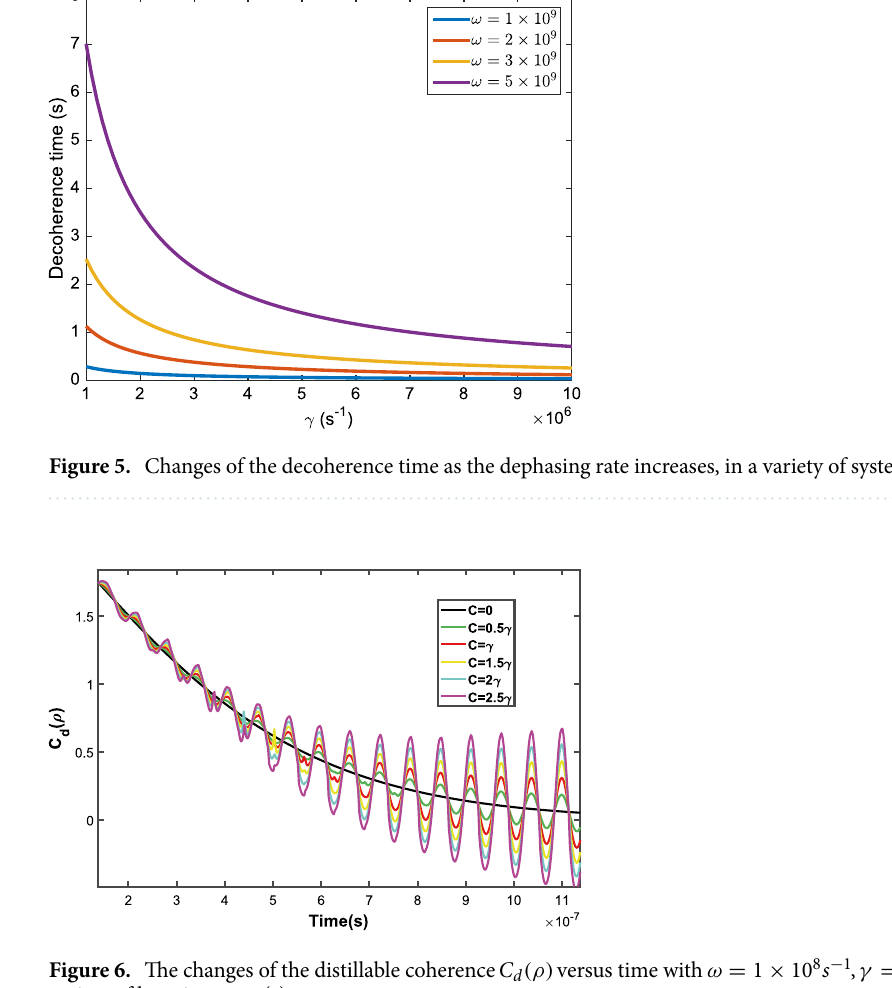
Figure 6. The changes of the distillable coherence C d (ρ) versus time with ω variety of hopping rates ( c